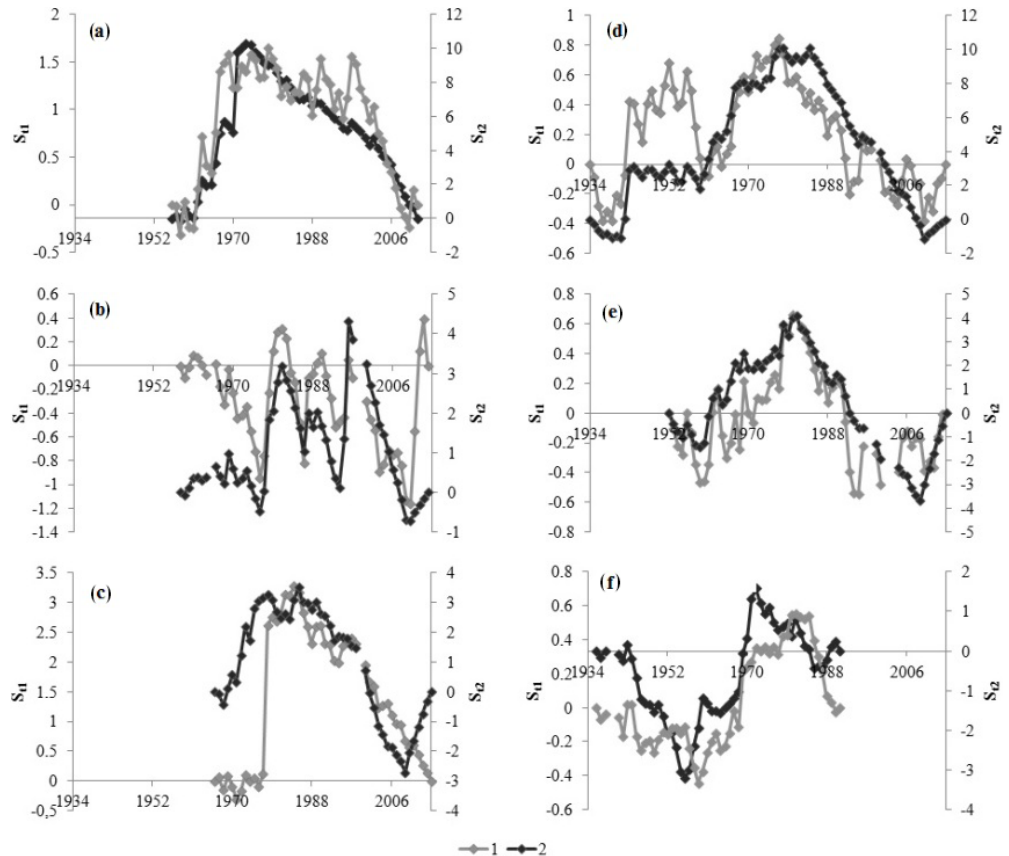
Figure 5. Trends in water discharge (1, S t1 ) and suspended sediment yield (2, S t2 ) variability in the Penzhina River (Kamenskoe gauge, a ), the Khairyuzova River (Khairyuzovo gauge, b ), the Udova River (Rus’ gauge, c ), the Avacha River (Elizovo gauge, d ), the Kirganick River (Kirganick gauge, e ), the Kamchatka River (Bol’shie Sheki gauge, f